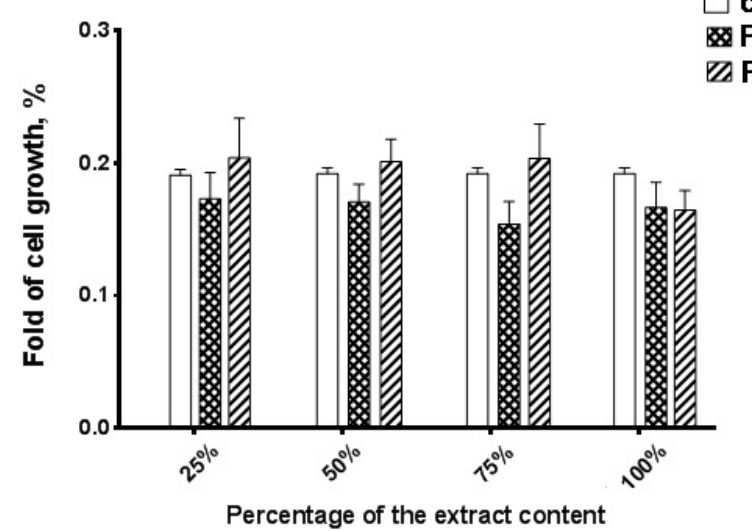
Figure 13. The effect of PUR and PUR-M scaffolds’ extracts on the in vitro growth of C2C12 cells studied by MTT assay after 72 h (* p < 0.05).